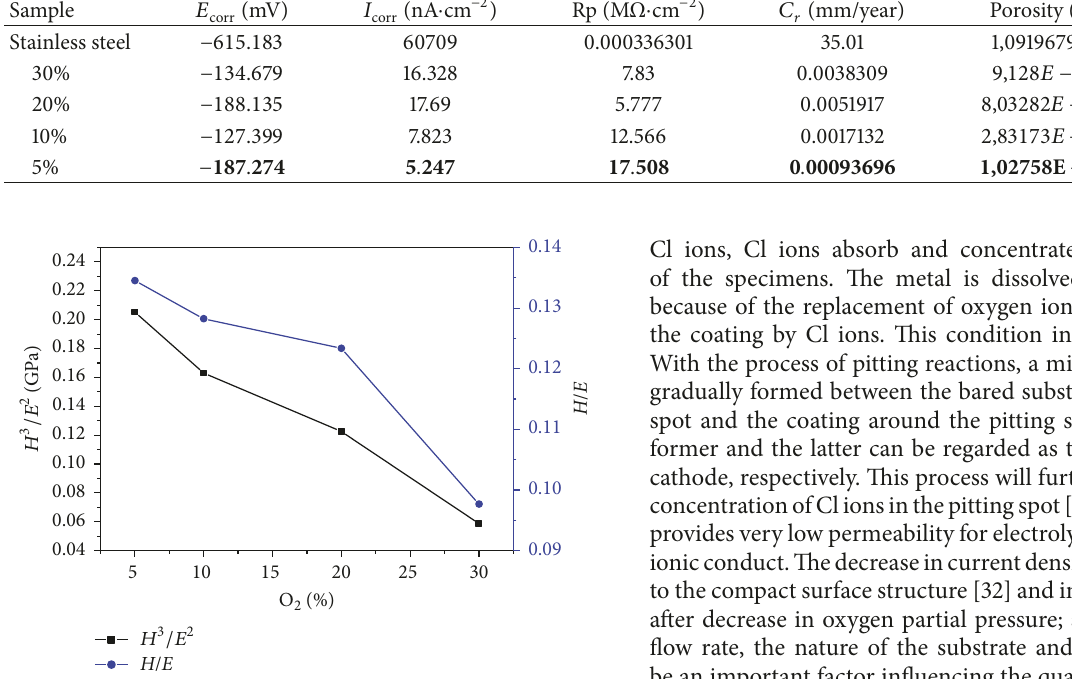
Figure 4: Variation of 𝐻/𝐸 and 𝐻 3 /𝐸 2 versus flux rate of oxygen.